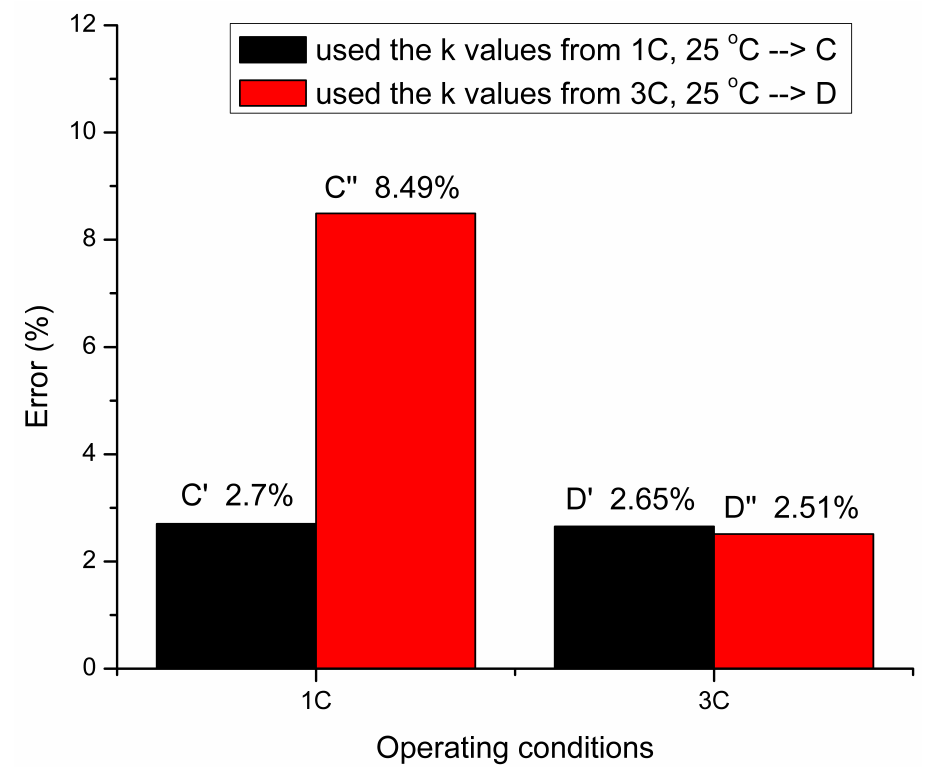
Figure 6. The estimation error between 1 and 3 C-rate at 25 ◦ C. The % value on top of each bar represent the % error of